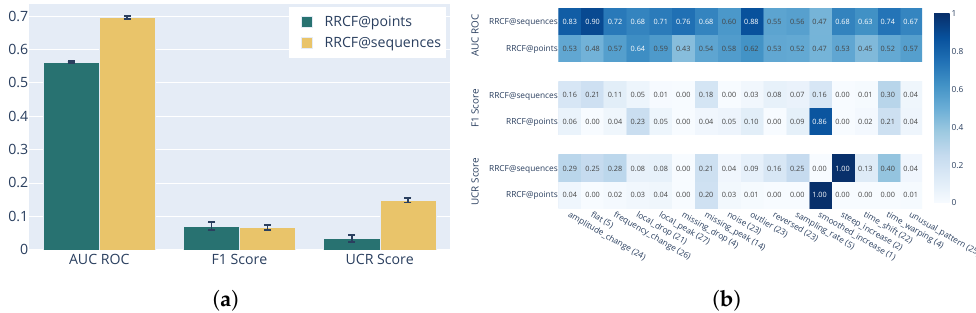
Figure 9. Comparing AUC ROC, F1- and UCR score of the baseline RRCF using the raw time series as input (RRCF@points) to RRCF applied on sliding window statistics (RRCF@sequences). ( a ) Macro- averaged performance metrics for each method. The error bars indicate the standard deviation caused by random effects over six repetitions of the experiment. ( b ) Macro-averaged AUC ROC, F1 and UCR scores for the 16 annotated anomaly types over six repetitions of the experiment. Next to the anomaly type, the number of timesseries containing that type is shown in